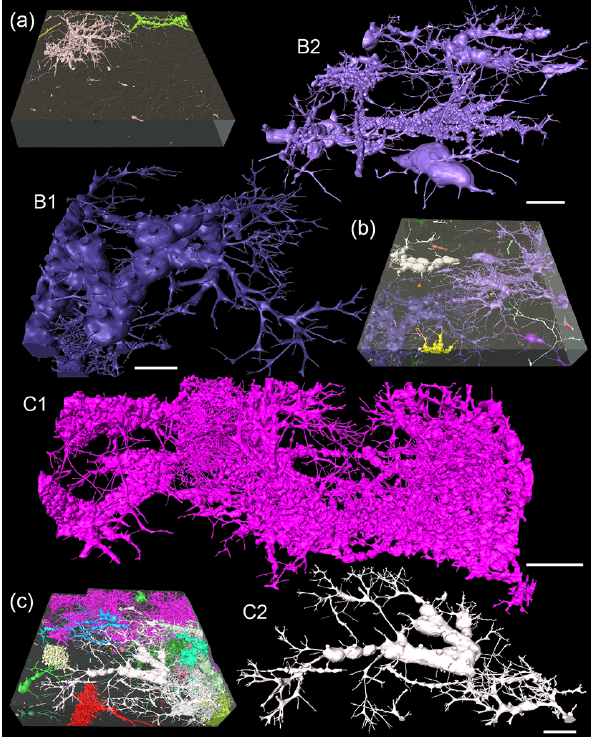
Figure 3. Micro-computed tomographic visualisation of bioerosion traces in experimental blocks deployed for 5–6 years. (a) The 5- year block showed a network of Entobia geometrica and speci- mens of Caulostrepsis isp. (A1–A3). (b) The 6-year block showed a cluster of E . cf. ovula (scales A1–A3 = 2mm; size of blocks is 90 × 90 × 18mm).